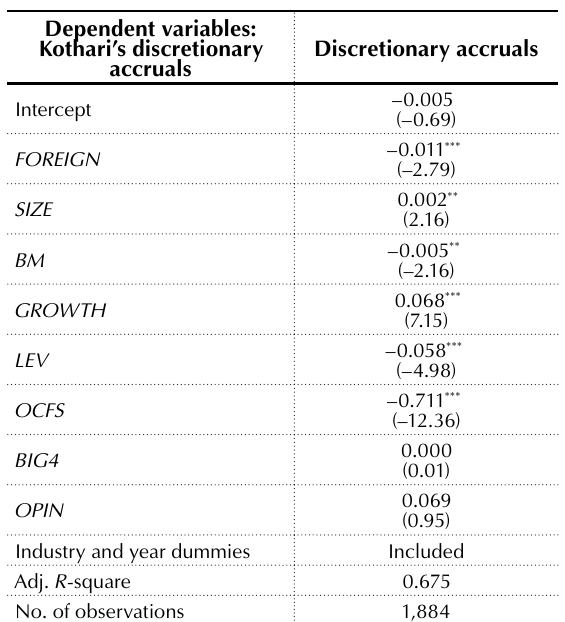
Table 4. The effect of the foreign directors in